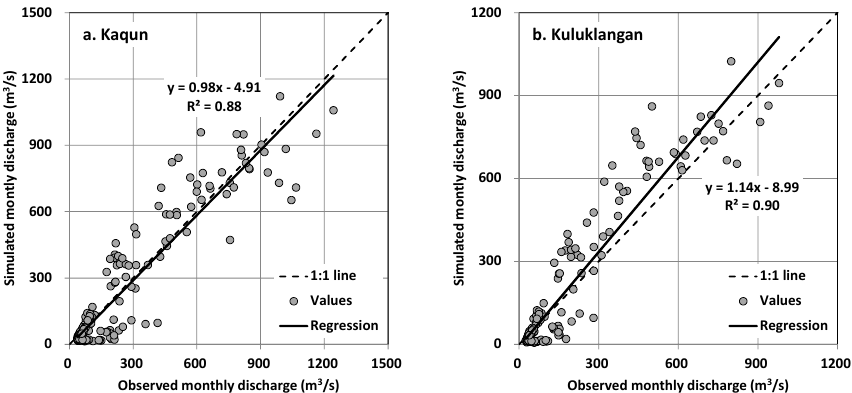
Figure 3. Comparisons between observed and simulated monthly streamflows at the Kaqun ( a ) and Kuluklangan ( b ) hydrological stations in the Yarkant River Basin from 1968 to 1989.